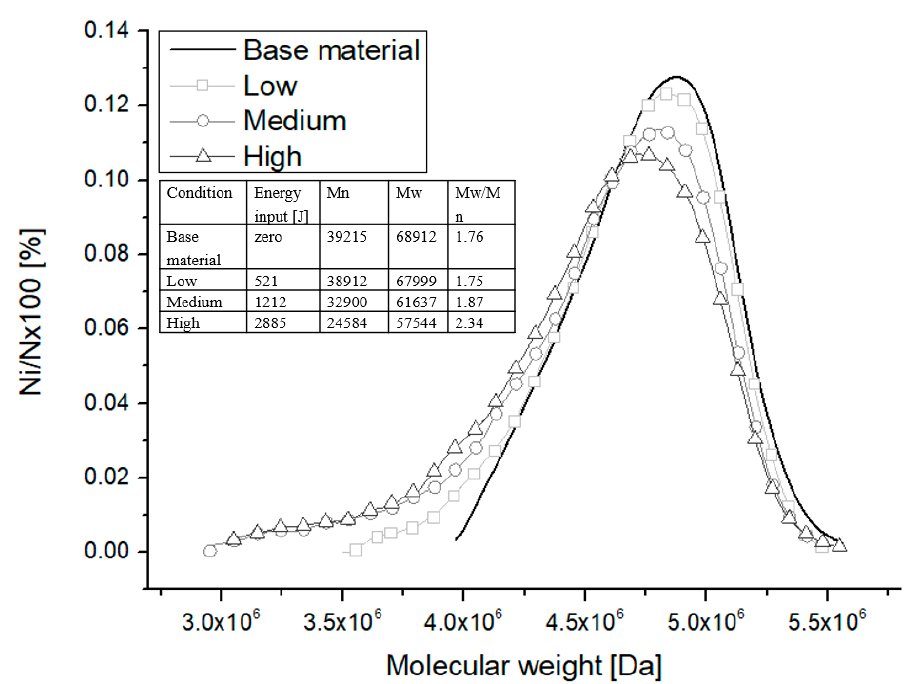
Figure 9. Molecular weight distribution curves of base material and PEI from F-ICJ joints at three levels of energy input: low ( E work = 521 J), medium ( E work = 1212 J), and high ( E work = 2885 J) energy inputs. Adapted from [42].